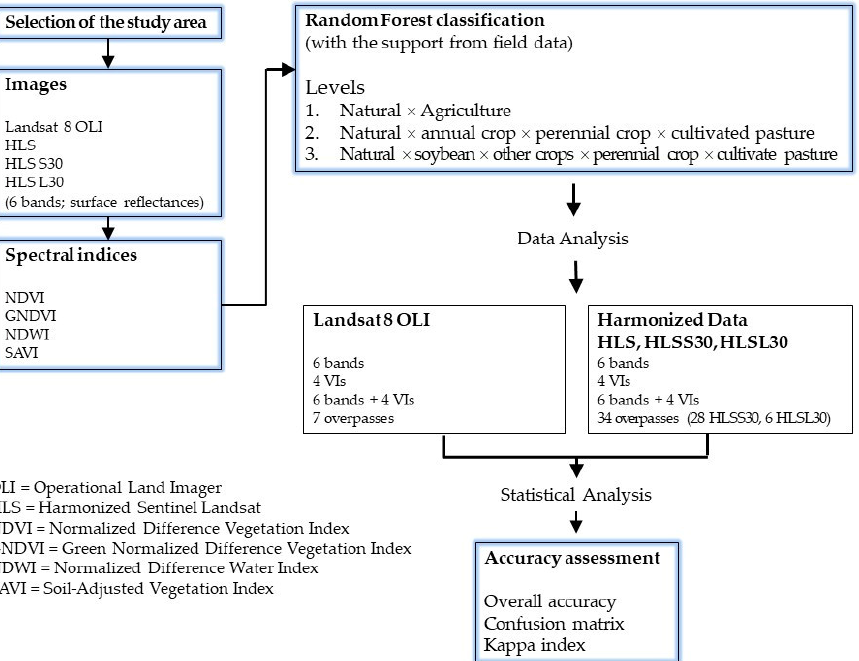
Figure 2. Flowchart showing the main steps of the method proposed in this study to discriminate soybean plantations from other representative land use and land cover (LULC) classes present in the study area.